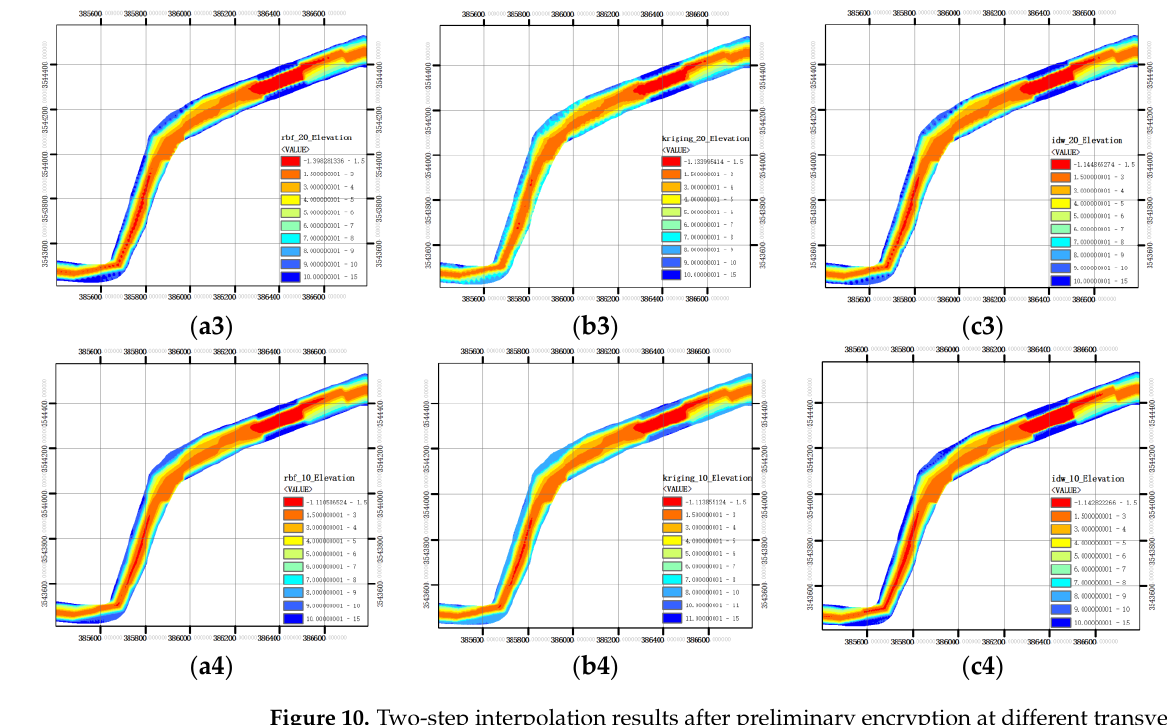
Figure 10. Two-step interpolation results after preliminary encryption at different transverse spac- ing and further interpolation with RBF, Kriging, and IDW under CGCS2000 coordinate system. ( a1 , b1 , c1 ) Transverse spacing of 80 m; ( a2 , b2 , c2 ): 40 m as transverse spacing; ( a3 , b3 , c3 ) 20 m as transverse spacing; ( a4 , b4 , c4 ) transverse spacing of 10 m; ( a1 – a4 ) RBF as a further interpolation method; ( b1 – b4 ): Kriging as a further interpolation method; ( c1 – c4 ): IDW as a further interpolation method.